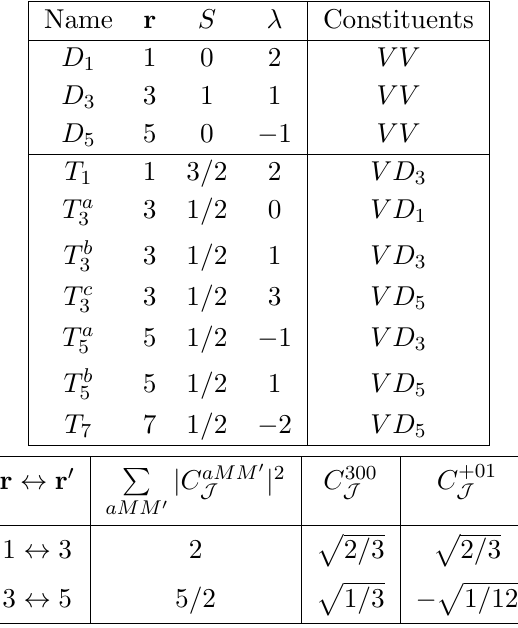
Table 1 . On the left quantum numbers of dark nuclear bound states (deuterium and tritium) for nucleons SU(2) L triplets. On the right group theory factors for the transition from an initial state with isospin r to a bound state with isospin r 0